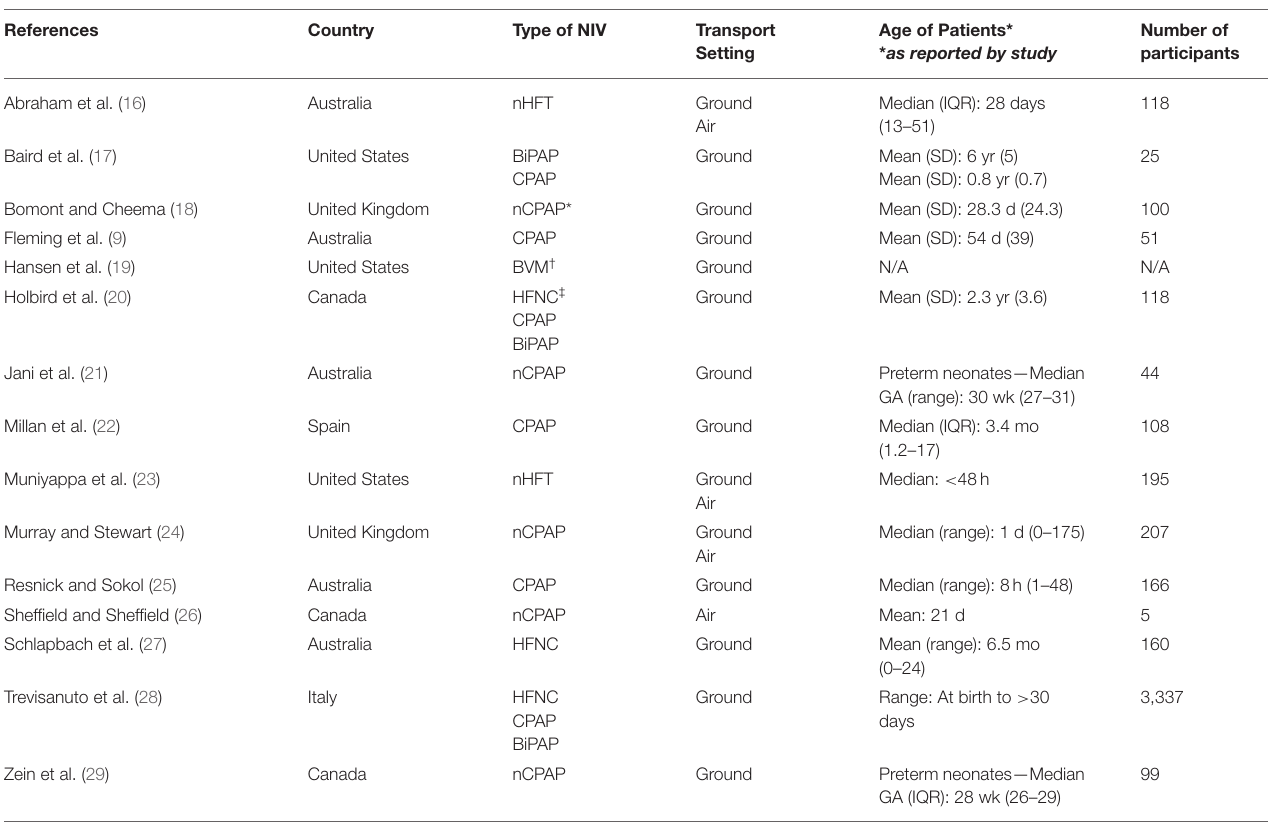
TABLE 1 | Summary table of included